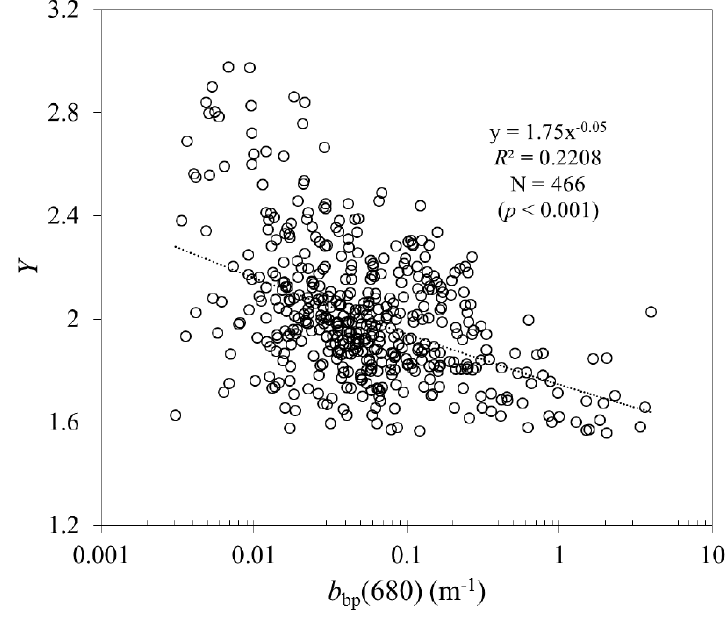
Figure 4. Scatter plot of the Y versus b bp (680) in situ values.